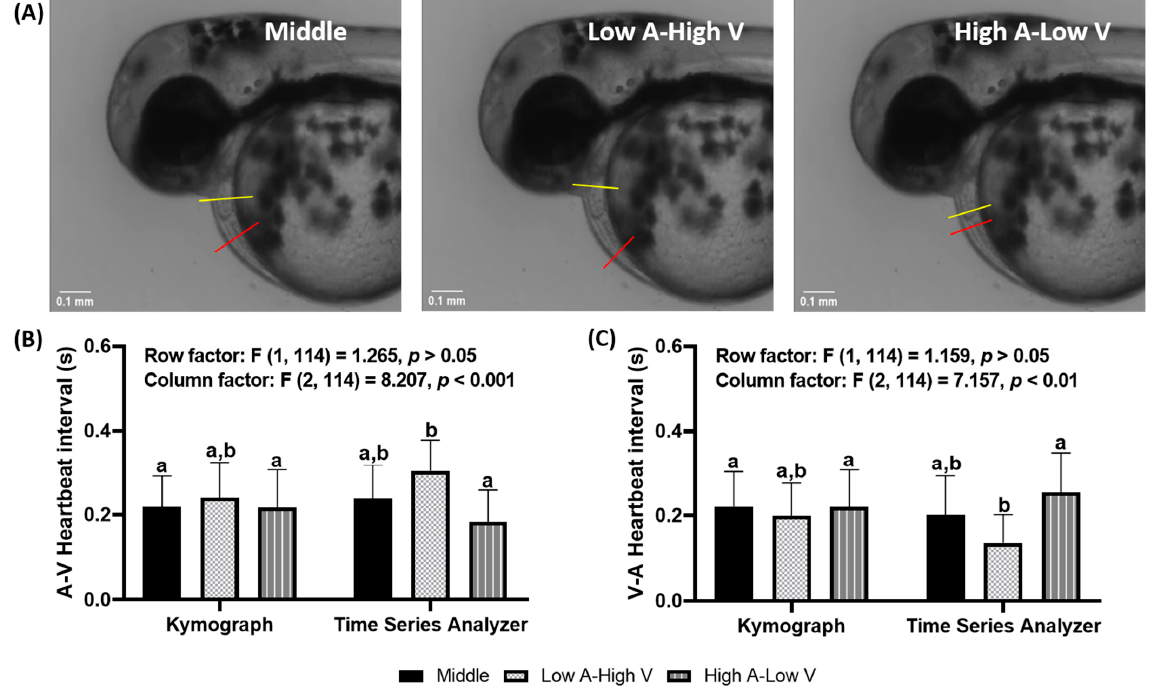
Figure 5. Effect of the selected region of interest (ROI) positioning on atrium-ventricle (A-V) and ventricle-atrium (V-A) interval measurement. ( A ) Three photos were showing the different positions of ROI when measuring heart rate in zebrafish embryos aged at 72 h post-fertilization. There are middle ventricle-middle atrium, high ventricle-low atrium, and high atrium-low ventricle positions (yellow lines represent the ROI location for ventricle, while red lines represent the ROI location for atrium). Comparison of kymograph (kymo) and time series analyzer (TSA) methods to measure zebrafish ( B ) atrium-ventricle interval and ( C ) ventricle-atrium interval. Data were calculated using a two-way analysis of variance (ANOVA), presented as mean ± SEM (* p < 0.5, n = 20). Different letters (a, b) on the error bars represent the significant differences ( p < 0.05).